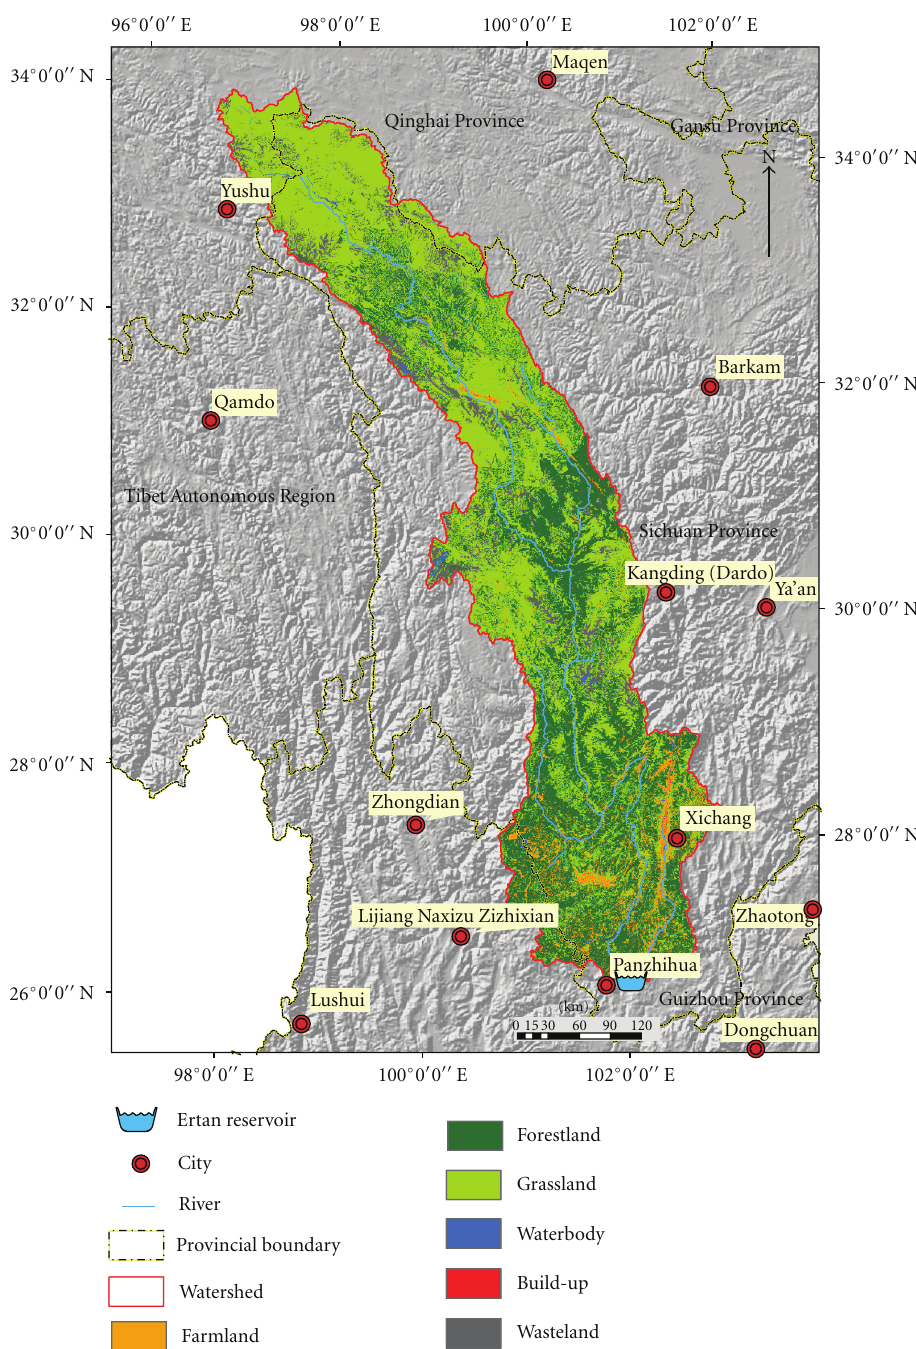
Figure 1: The location of the watershed of Ertan